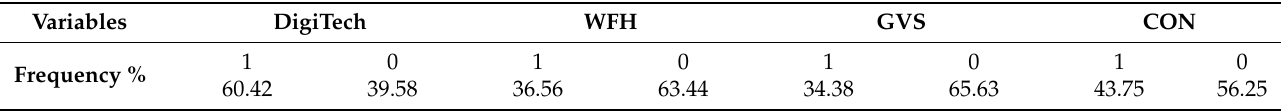
Table 4. Frequency of binary